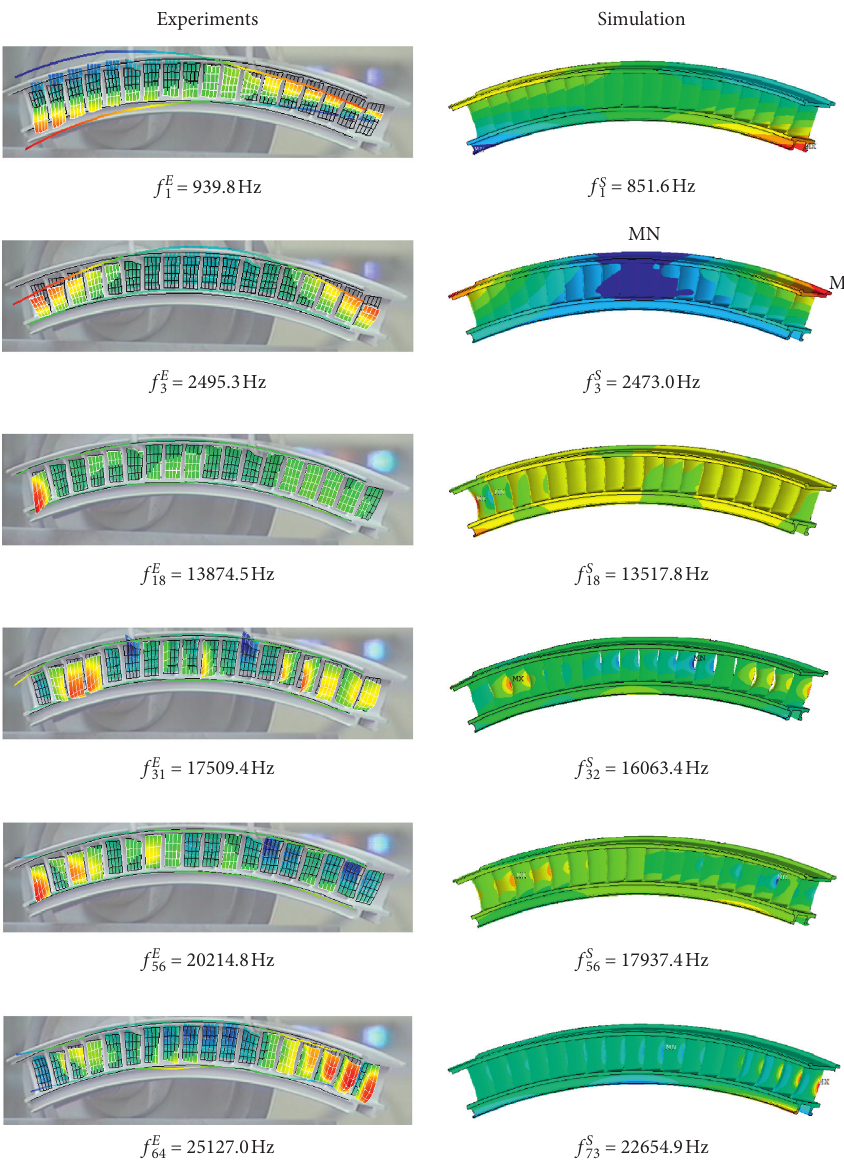
Figure 8: Comparison of experimental and simulated mode shapes and natural